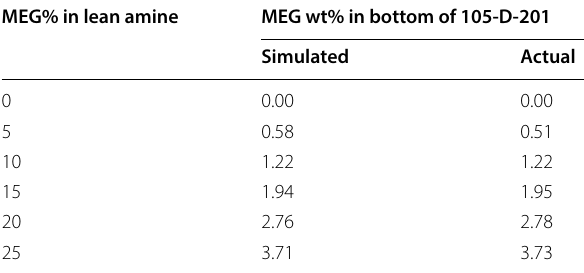
Table 7 Comparing actual and simulated data of MEG wt% in the bottom of 105-D-201